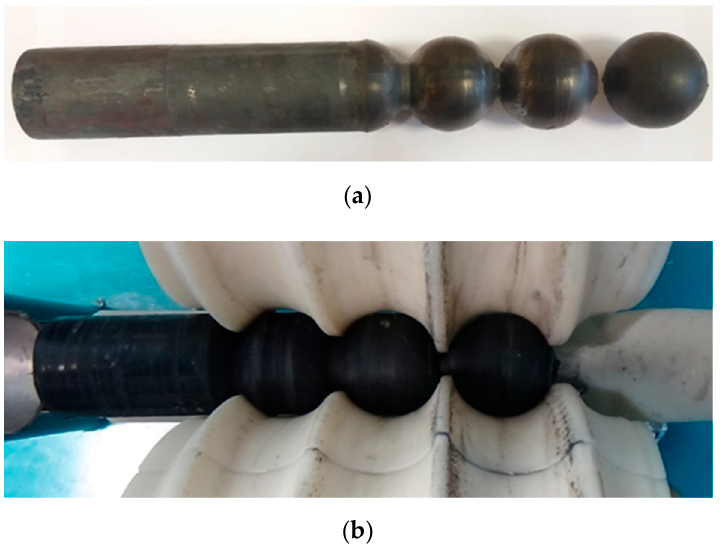
Figure 11. The rolled item seen during helical rolling of steel ( a ) and plasticine balls ( b